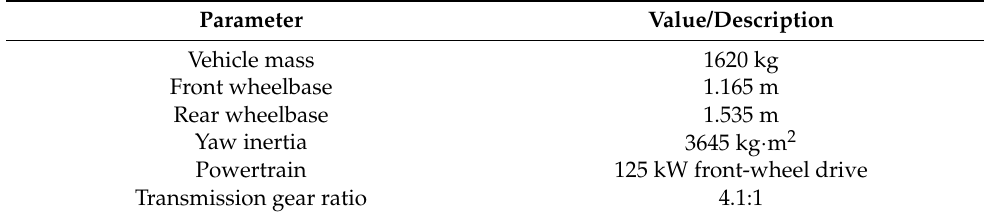
Table 3. Parameters of vehicle